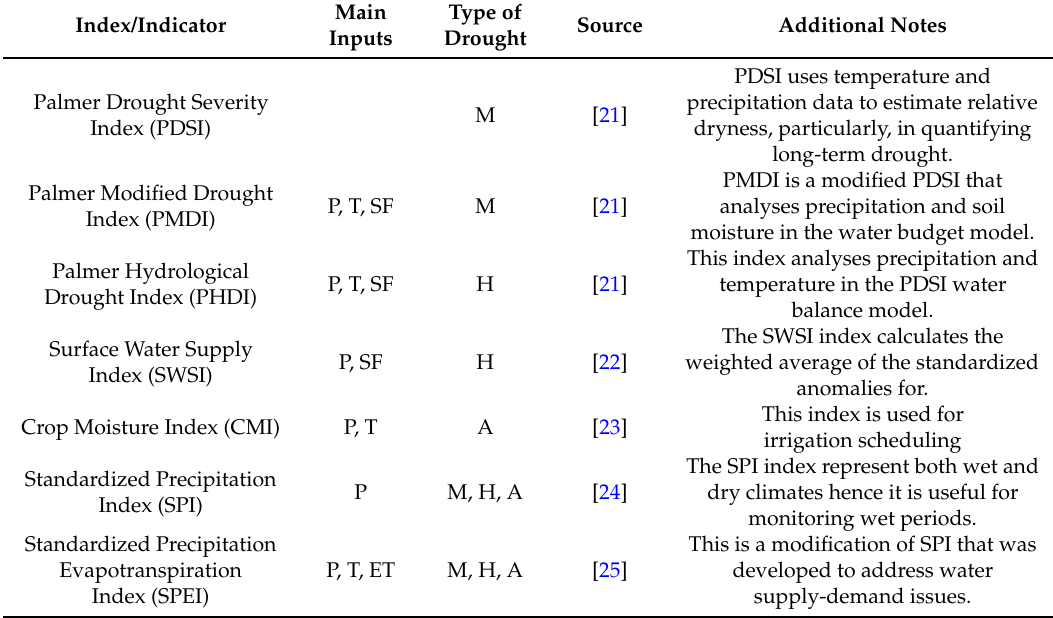
Table 1. Summary of selected drought indices. P = precipitation, T = temperature, SF = streamflow, ET = Evapotranspiration, M = meteorological, H = hydrological and A = agricultural. Table adopted from Zargar et al.